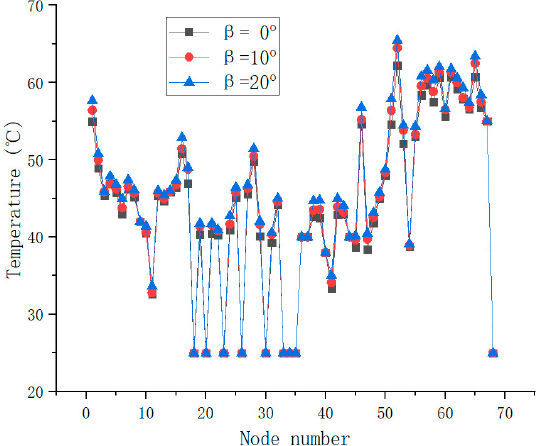
Figure 11. The TFD with the different helical angles of the gear.